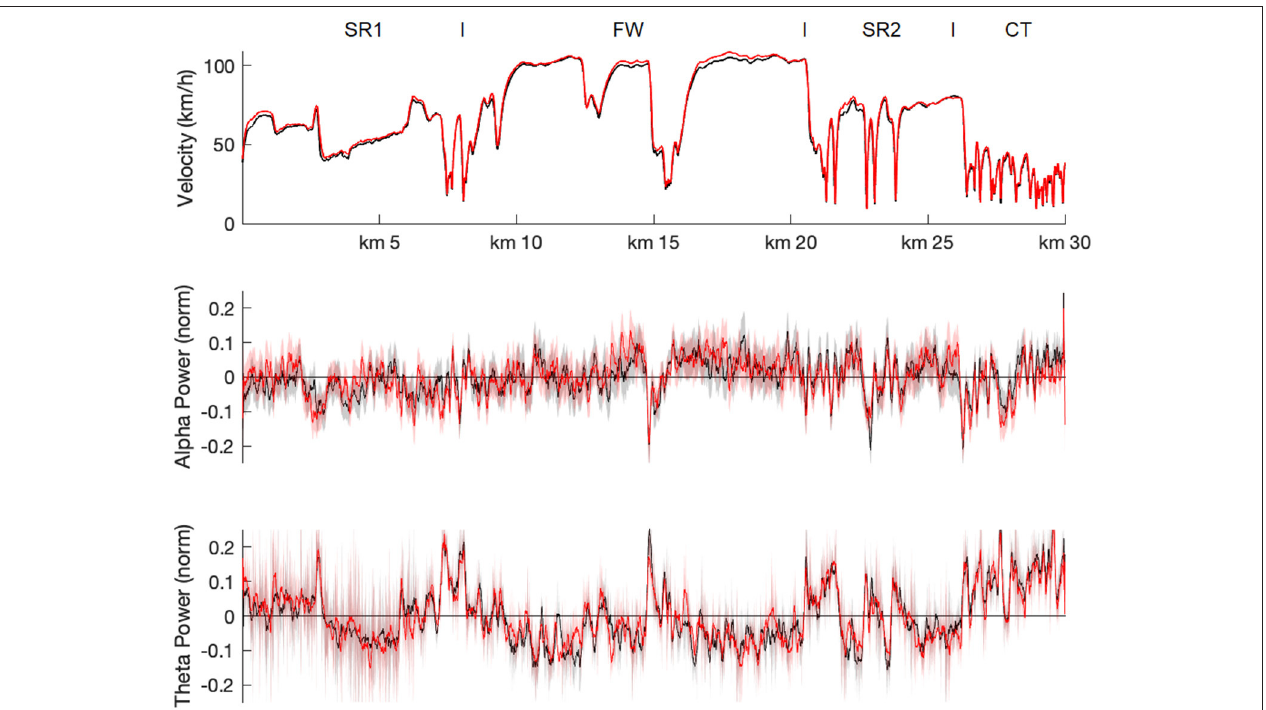
FIGURE 4 | Track-based analyses of EEG parameter. Mean z-transformed alpha (middle row) and theta (lower row) power fractions as function of driving route for MP1 (black) and MP2 (red), shaded by their 95% confidence intervals. For comparison, mean driving speed (upper row) is also shown. Note that for each time point individual alpha and theta values of each participant were assigned to fix waypoints and then averaged separately for 10-meter track segments. SR1, first state road; FW, freeway; SR2, second state road; CT, city